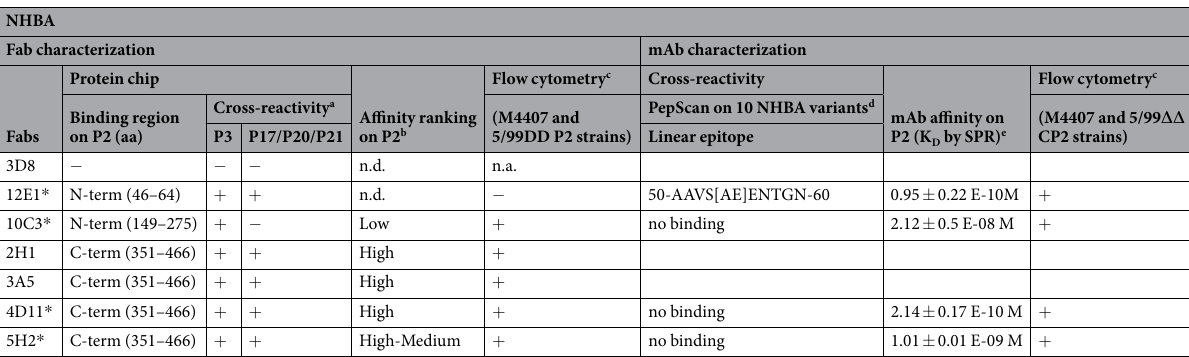
Table 3. Main features of selected anti-NHBA Fabs and mAbs. * ,a,b,c,e See Table 2. d For mAbs